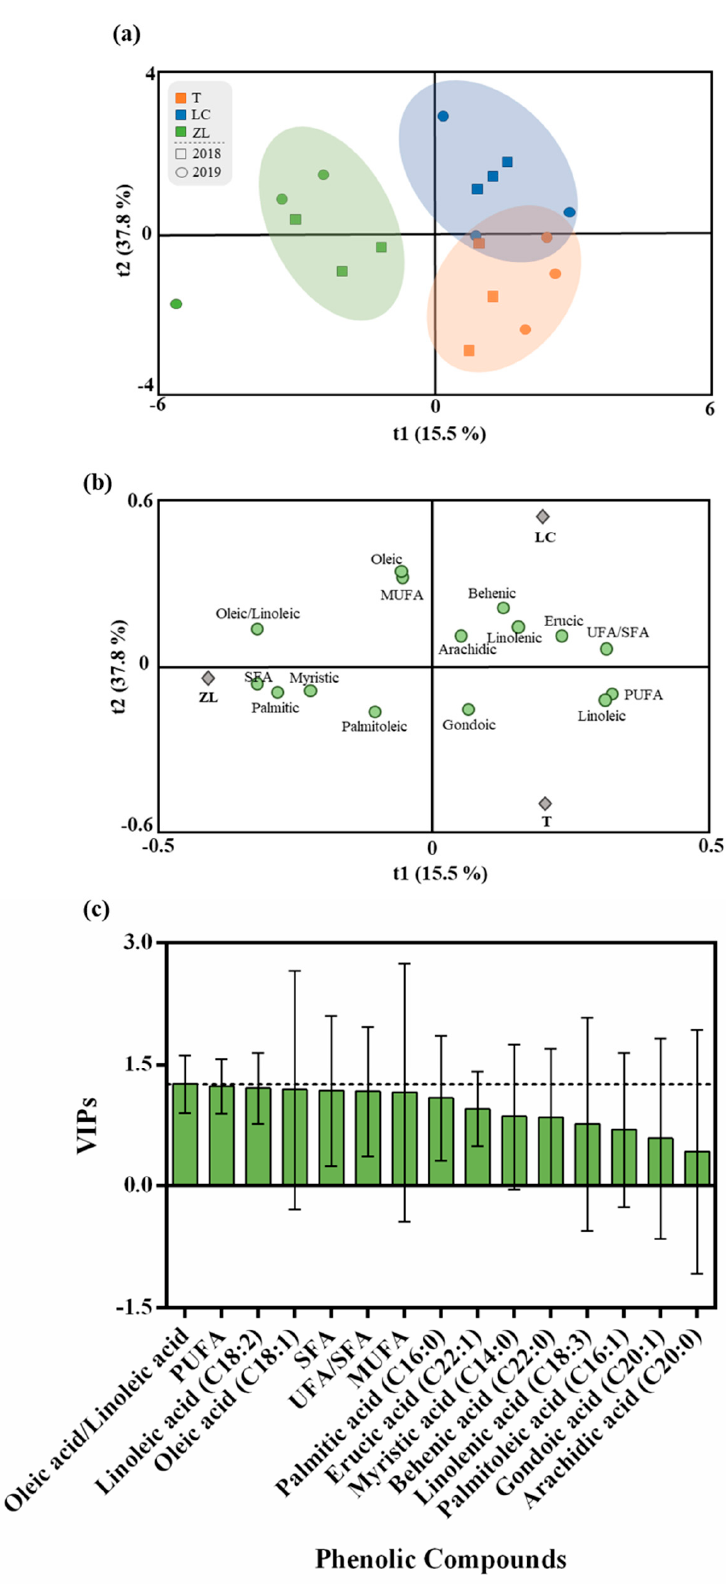
Figure 5. ( a ) Scores plot and ( b ) loadings plot of the first two factors of the OPLS-DA model built with the phenolic profile of the olive oil according to the soil treatment. ( c ) Phenolic compounds ranked by their VIP scores.